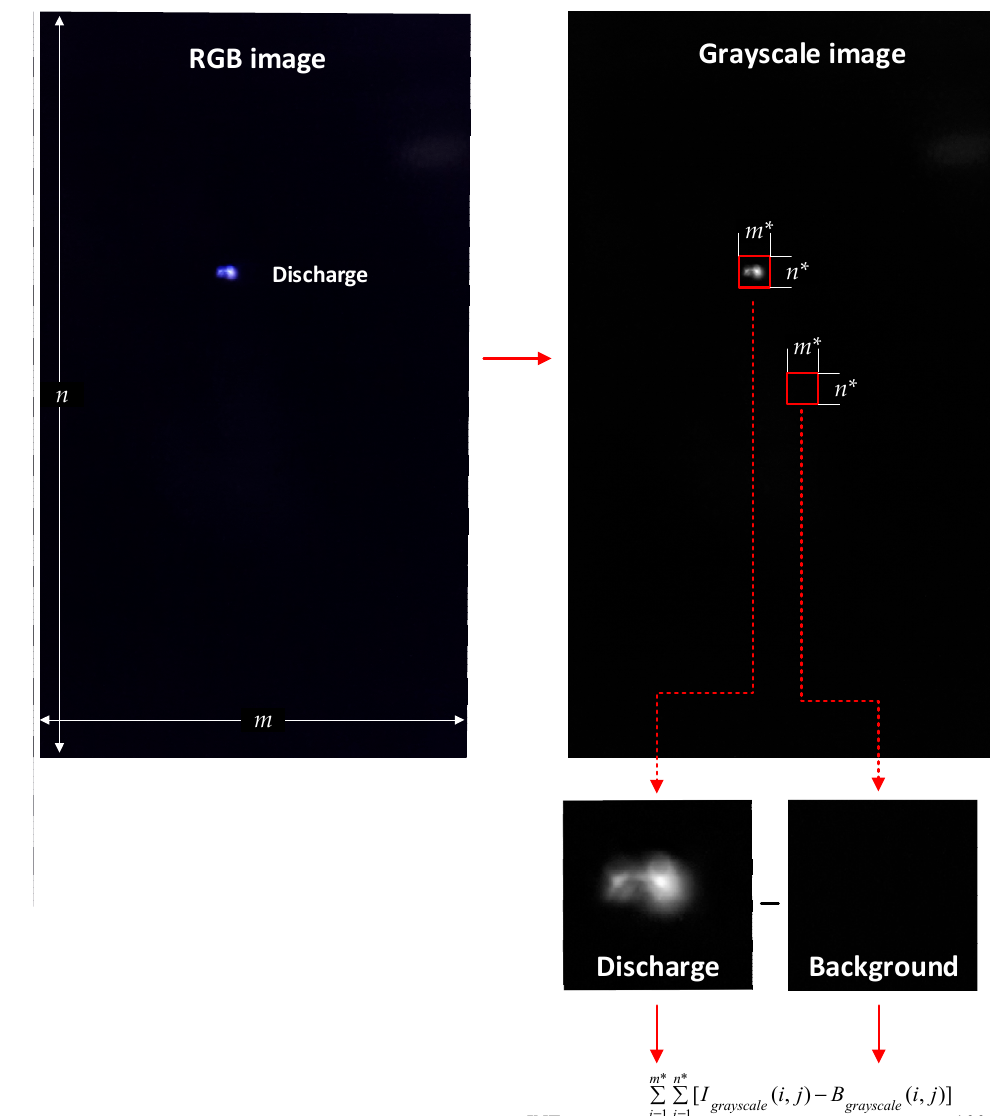
Figure 3. Summary of the image processing to determine the intensity of the discharges from digital RGB images.